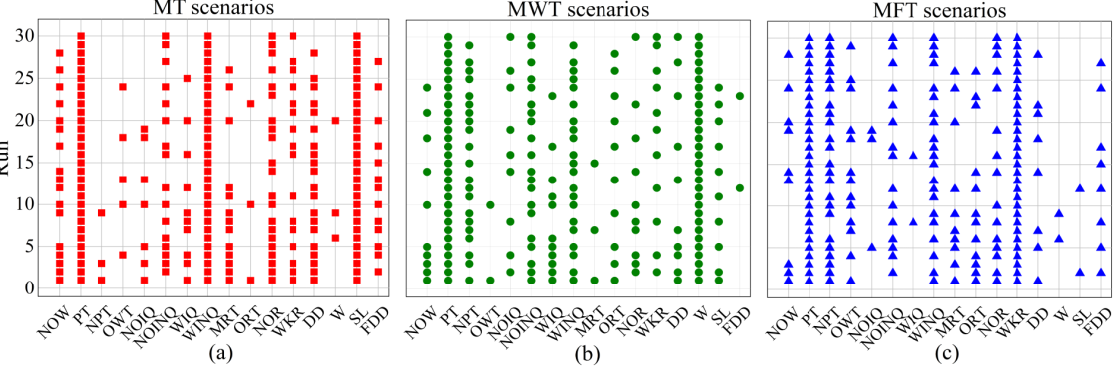
Figure 7. The matrix plot of the feature selection results of the SGP-FS Algorithm for the three ob- jectives. (a): Selected terminals using the SGP-FS algorithm for the MT scenarios, (b): Selected ter- objectives. ( a ): Selected terminals using the SGP-FS algorithm for the MT scenarios, ( b ): Selected minals using the SGP-FS algorithm for the MWT scenarios, and (c): Selected terminals using the terminals using the SGP-FS algorithm for the MWT scenarios, and ( c ): Selected terminals using the SGP-FS algorithm for the MFT scenarios. SGP-FS algorithm for the MFT